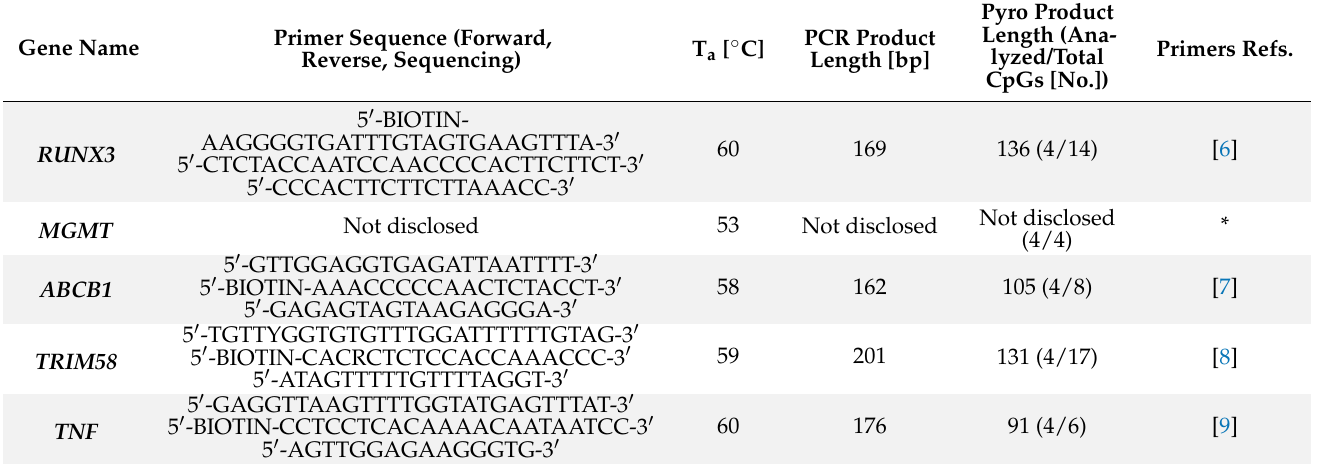
Table 1. Primer sequences, product lengths and other pyrosequencing characteristics for each